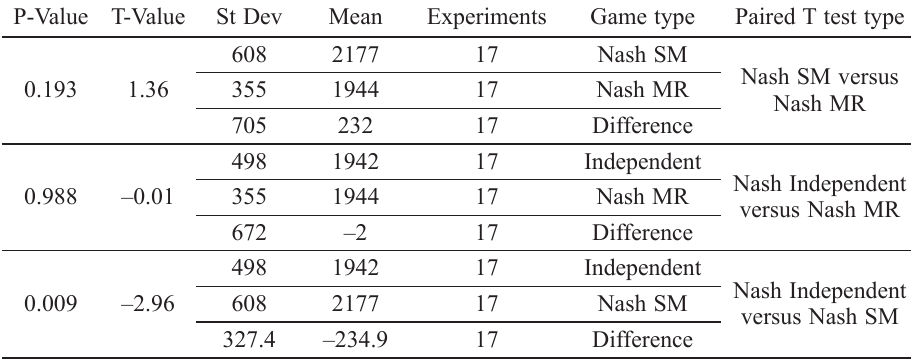
Table 8. Comparison results from three coalition and independent